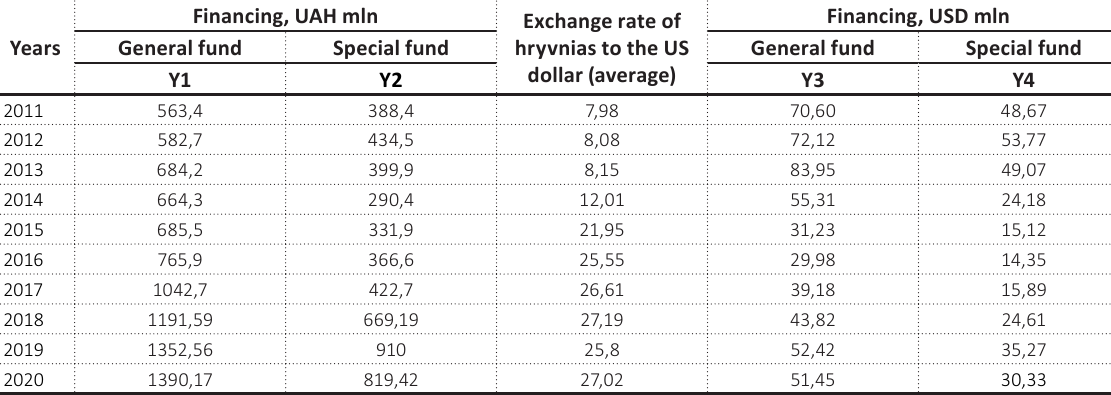
hryvnias to the US dollar (average)